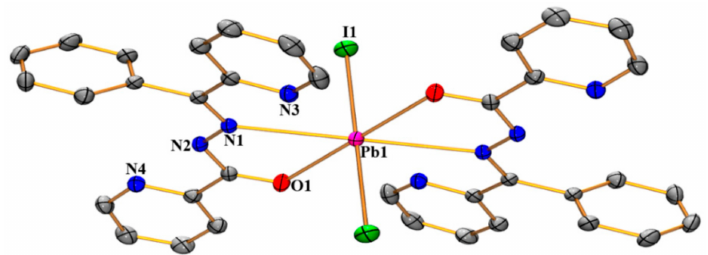
Figure 5. Molecular view of compound ( 2 ) with partial atom numbering. The unlabeled counterpart is produced through the symmetry ( − x, 2 − y, 1 − z). Thermal ellipsoids have been generated at 30% probability.